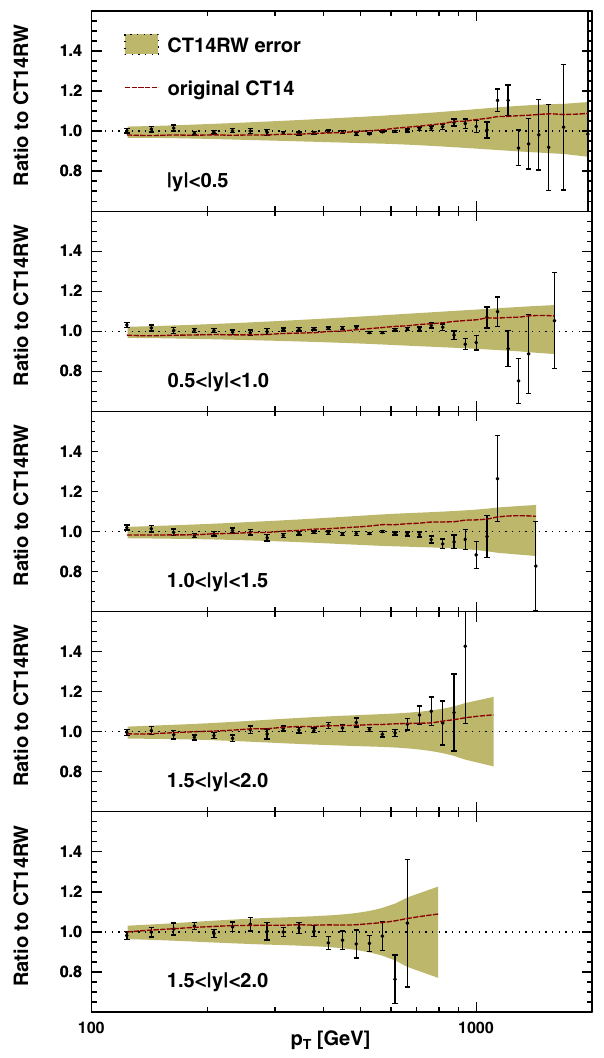
Fig. 6 ComparisonofCMS7TeVinclusivejetmeasurements[34]and NLO predictions obtained using the CT14 NLO PDFs [5] reweighted withthe5.02TeVdijetdata[4].Theoptimalsystematicshiftsinthecor- related experimental uncertainties are applied to the data points (simi- larlyasinRef.[15])andonlystatisticaluncertaintiesareshown.Dashed red lines show the ratio of predictions with the original CT14 PDFs to those with the reweighted PDFs